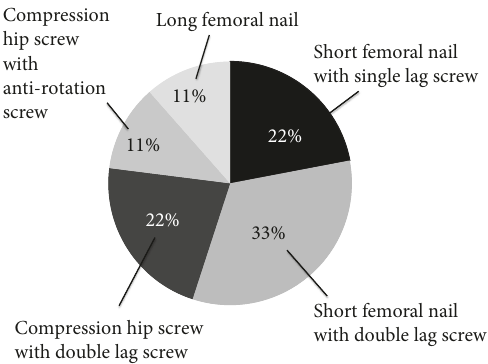
Figure 4: Of patients who underwent osteosynthesis for Type 1-2- 3(-4) fractures, treatment consisted of a short femoral nail with single lag screw in 22%, a short femoral nail with double lag screw in 33%, a compression hip screw with double lag screw in 22%, a compression hip screw with antirotation screw in 11%, and a long femoral nail in